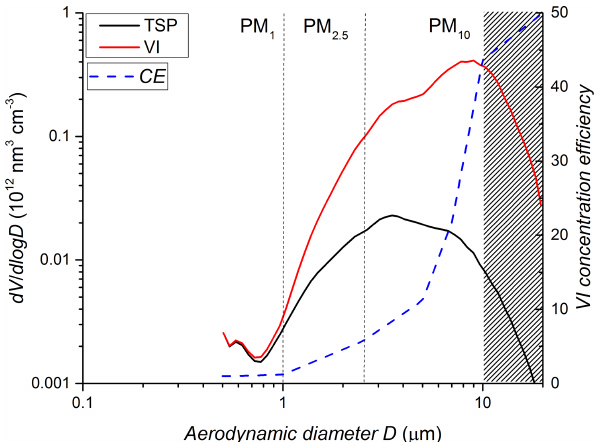
Figure 4. Average aerodynamic volume size distribution spectrum measured by APS between 1 and 30 April 2016 (black line) and the predicted spectrum of aerosol concentrated using the virtual im- pactor (red line). Blue line represents the virtual impactor concen- tration efficiency measured in laboratory (Sect. S1). Shaded area denotes the particles larger than